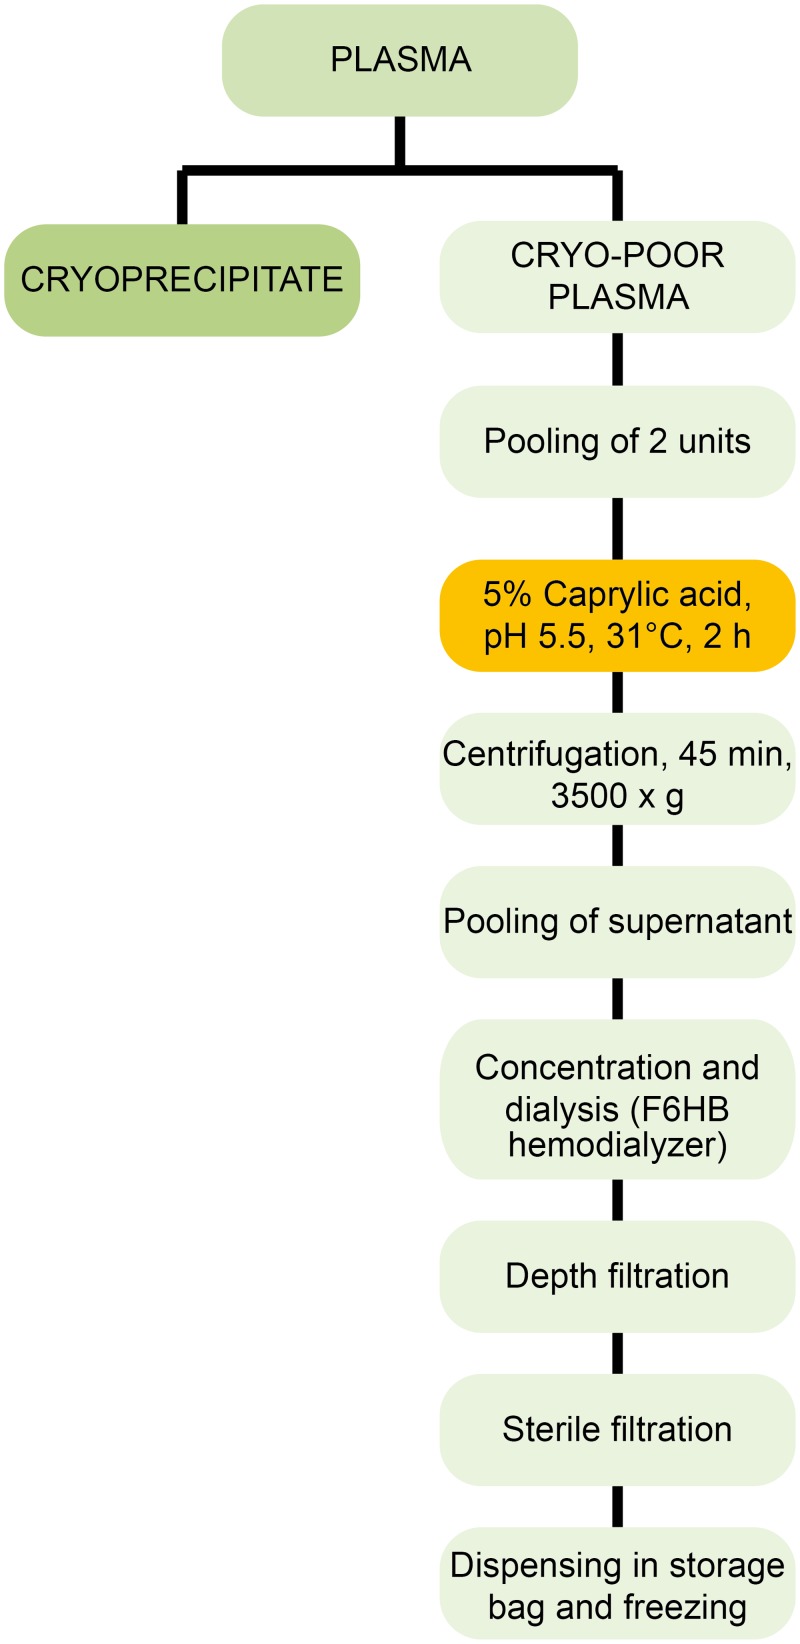
Preparation scheme of the IgG-enriched plasma fraction.